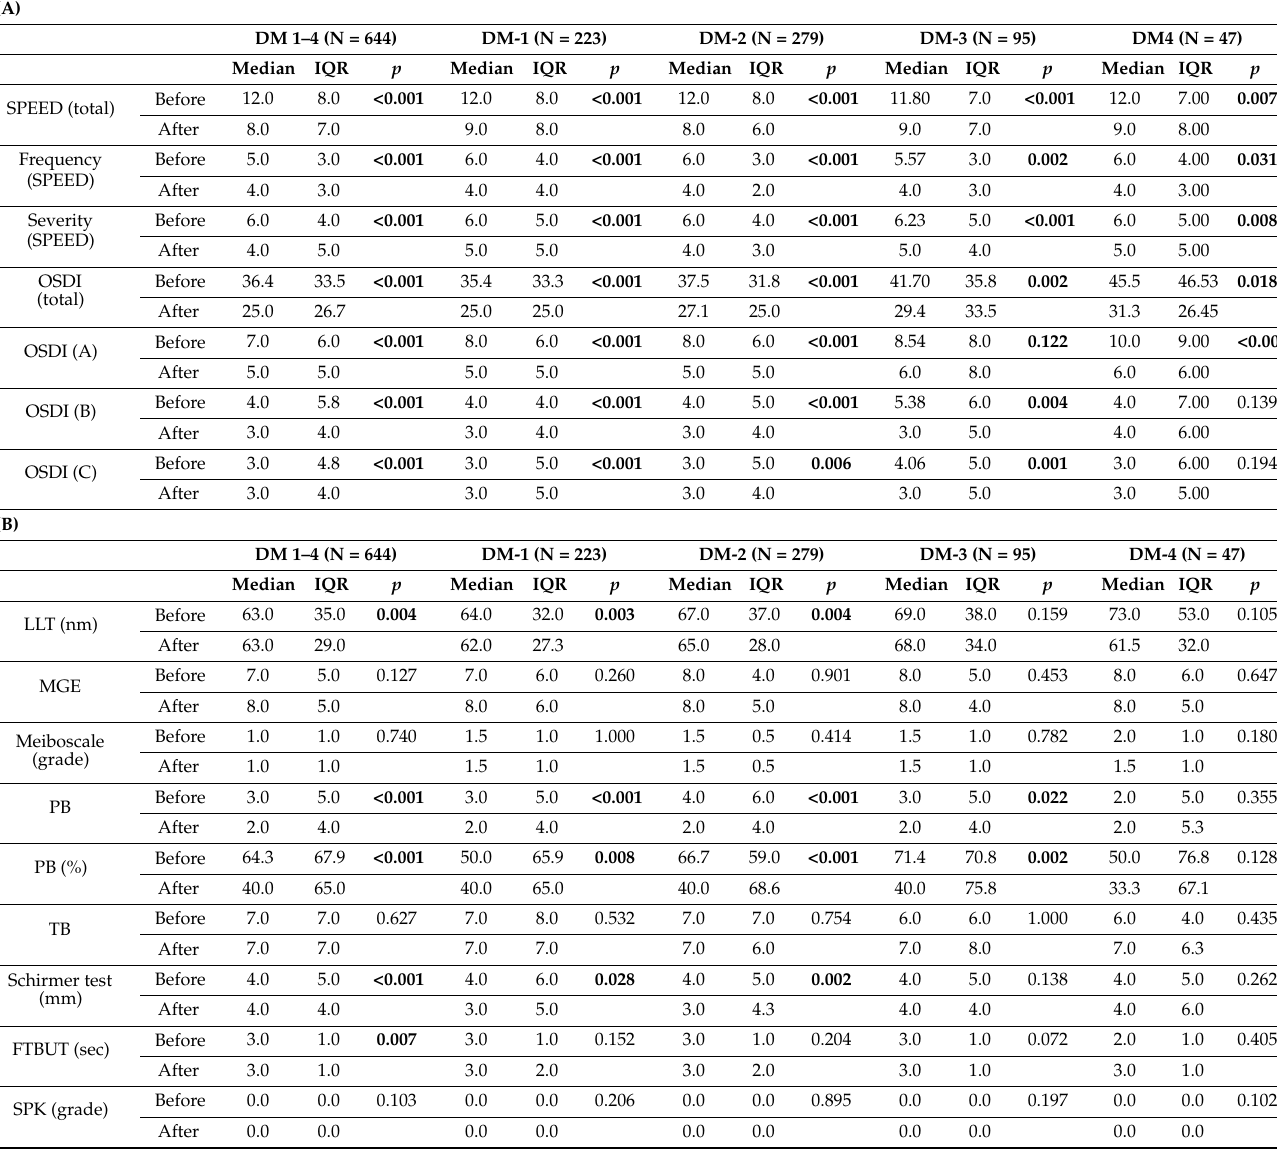
Table 7. Summary of subjective and objective dry-eye parameters before and after lid hygiene. (A) Summary of subjective symptoms before and after lid hygiene. (B) Summary of objective signs before and after lid